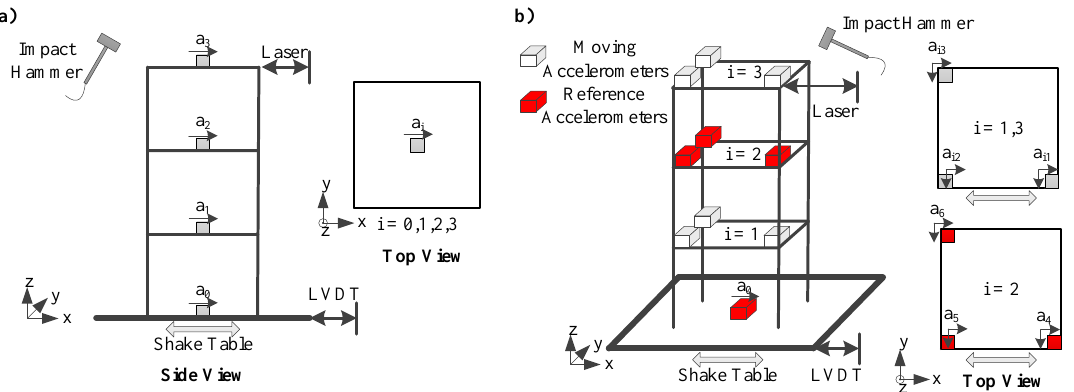
Figure 5. Test setup and sensor layout for: ( a ) 2D; and ( b ) 3D